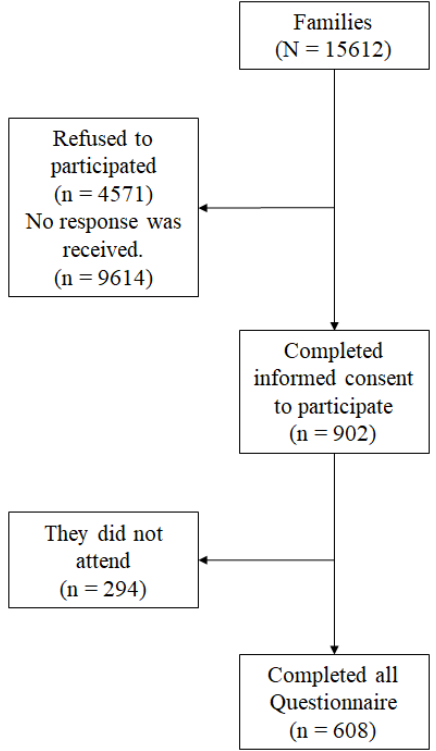
Figure 1. Sample flowchart. N : total; n : subtotal.